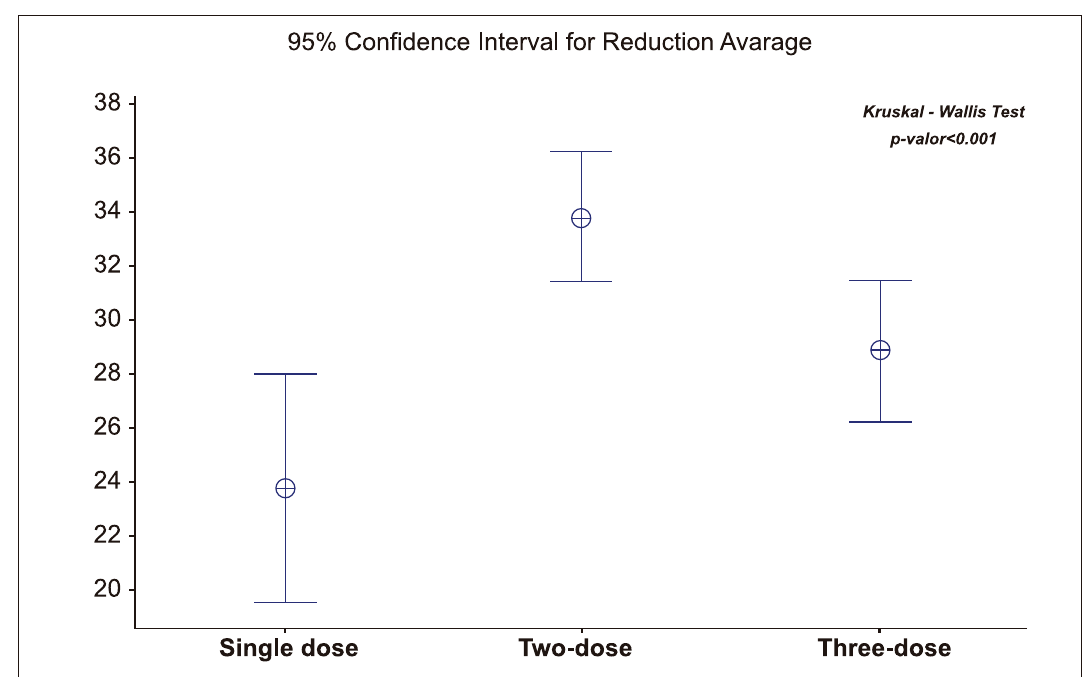
Fig 2. Average of the capillary glycemia reduction before and after half an hour of the applications between the treatments.